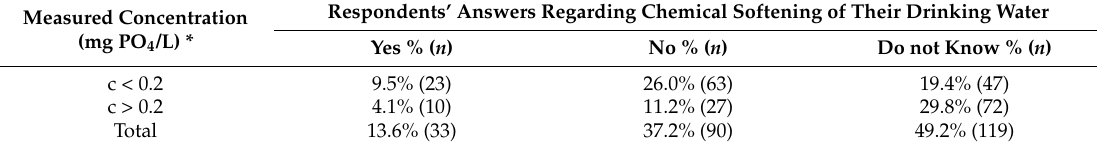
Table 1. Respondents’ answers regarding chemical treatment and measured phosphate concentrations in drinking